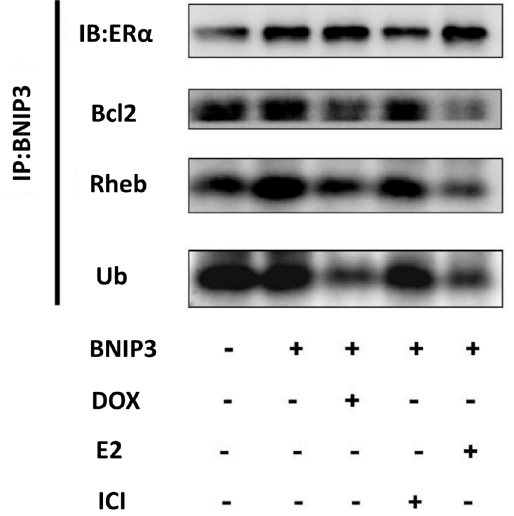
Figure 4. ER α /E2 inhibited apoptosis and autophagy by binding to BNIP3. Tet-on ER α H9c2 cells were transfected with BNIP3 (6 μ g), incubated for 6 h, and then exposed to doxycycline (1 μ g/mL) or ICI (0.5 μ M, ER inhibitor) for 1 h, followed by exposure to E2 (10 nM) in serum-free medium for 18 h. Cell proteins were extracted for immunoprecipitation assay, incubated with primary anti-BNIP3 antibody, and precipitated with protein-G agarose. Immunoblot assay was used to detect the binding of BNIP3 with ER α , Bcl-2 (anti-apoptotic protein), Rheb (anti-autophagic protein), or Ub (ubiquitin, degradation signal protein). E2: 17 β -estrodiol, ICI: ICI 182,780.